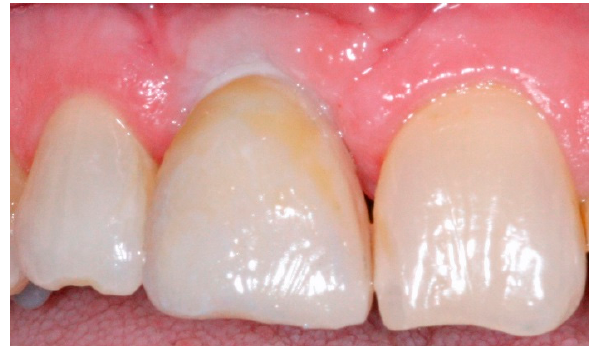
Figure 7. Provisional crown restoration for anterior implant.